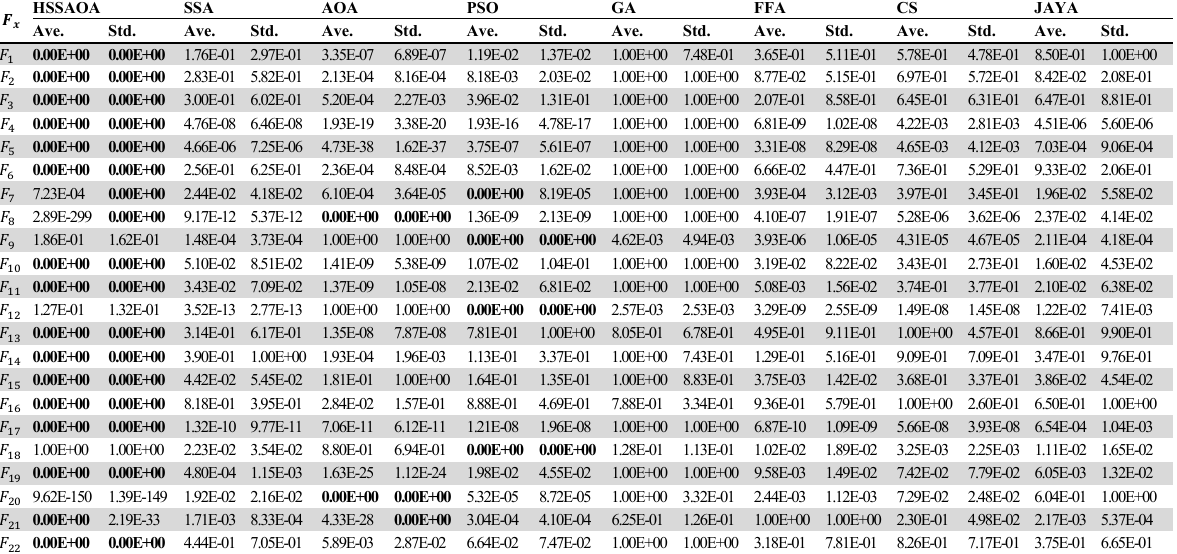
The results of the algorithms analyzed with different search agents, the same iteration and the number of independent runs were grouped and named. Named Group 1 for 30 search agents/100 iterations/30 independent runs, Group 2 for 50 search agents/100 iterations/30 independent runs, and Group 3 for 100 search agents/100 iterations/30 independent runs. Table 3 contains the average and standard deviation results of the optimized benchmark functions according to Group 1. Normalized (0-1) average (Ave.) and standard deviation (Std.) results of optimized benchmark functions according to Group 1 HSSAOA 𝑭 𝒙